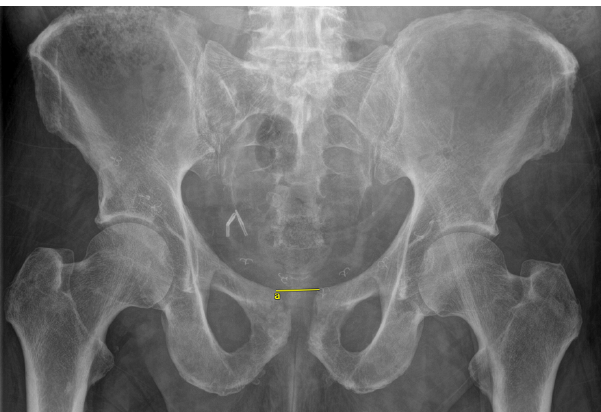
Figure 1. Anterior–posterior radiograph of the pelvis at final follow-up, with the yellow line demonstrating the measurement for pubic symphysis diastasis. The measurement value in this radio- graph was 28.6mm (a) .